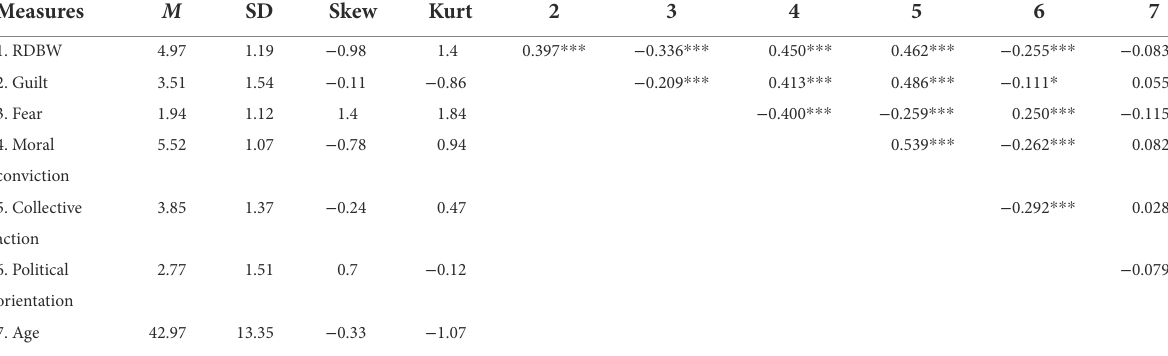
TABLE 1 Descriptive statistics and correlations between study